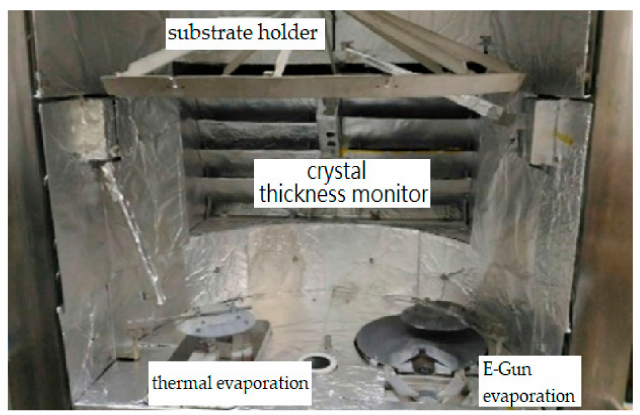
Figure 1. Combination of thermal and electron beam evaporation in the coating